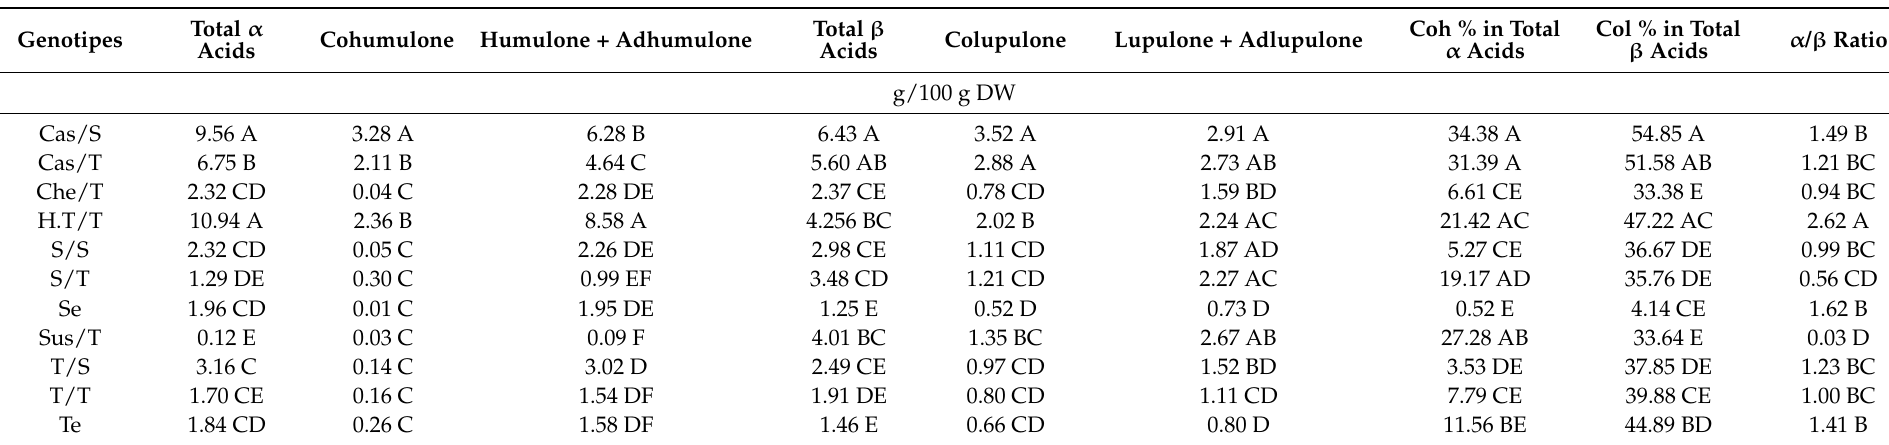
Table 2. Average bitter acid content in dry cones hops of wild Italian germplasm and commercial cultivar, determined by